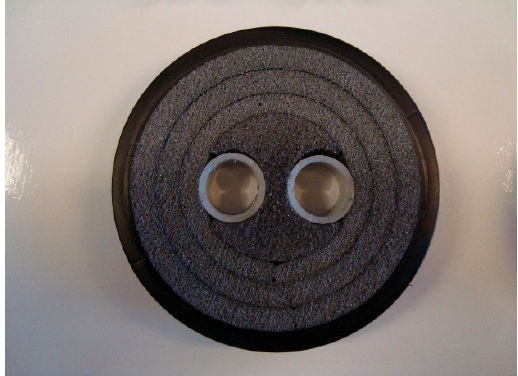
Figure 2. Cross-section of the twin